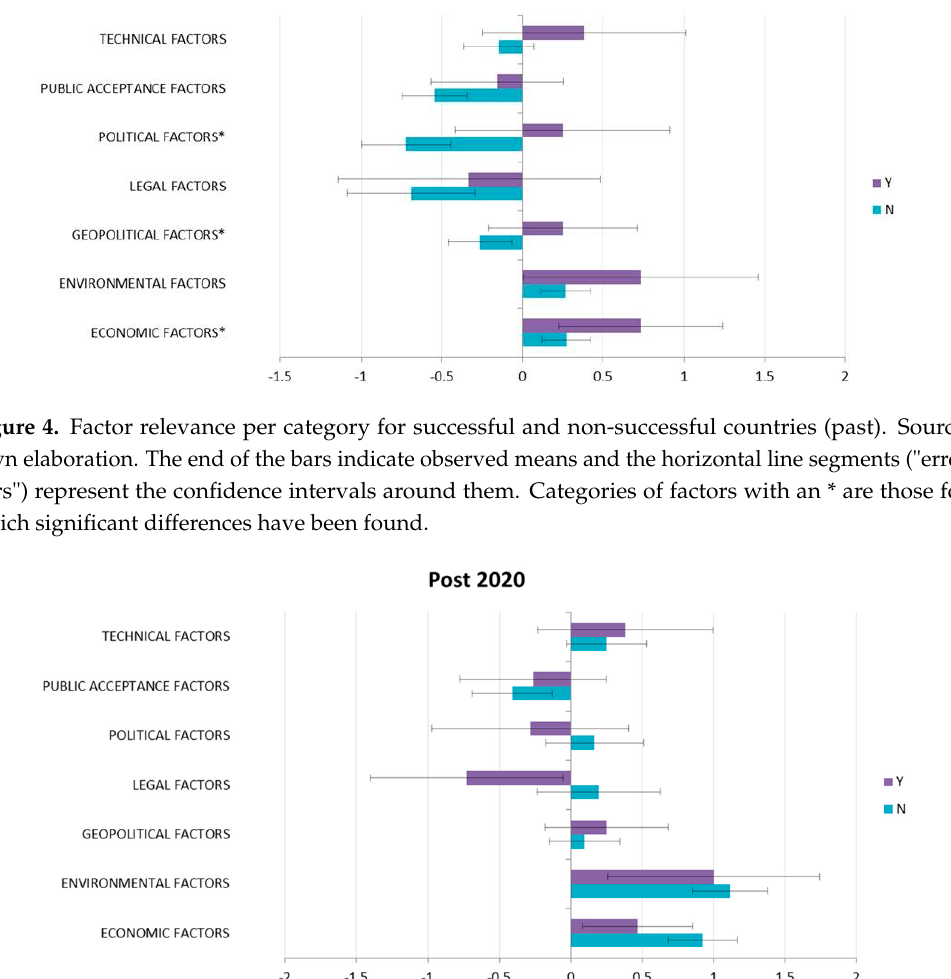
Figure 5. Factor relevance per category for successful and non-successful countries (future). Source: Own elaboration. The end of the bars indicate observed means and the horizontal line segments ("error bars") represent the confidence intervals around them. No significant differences have been found.